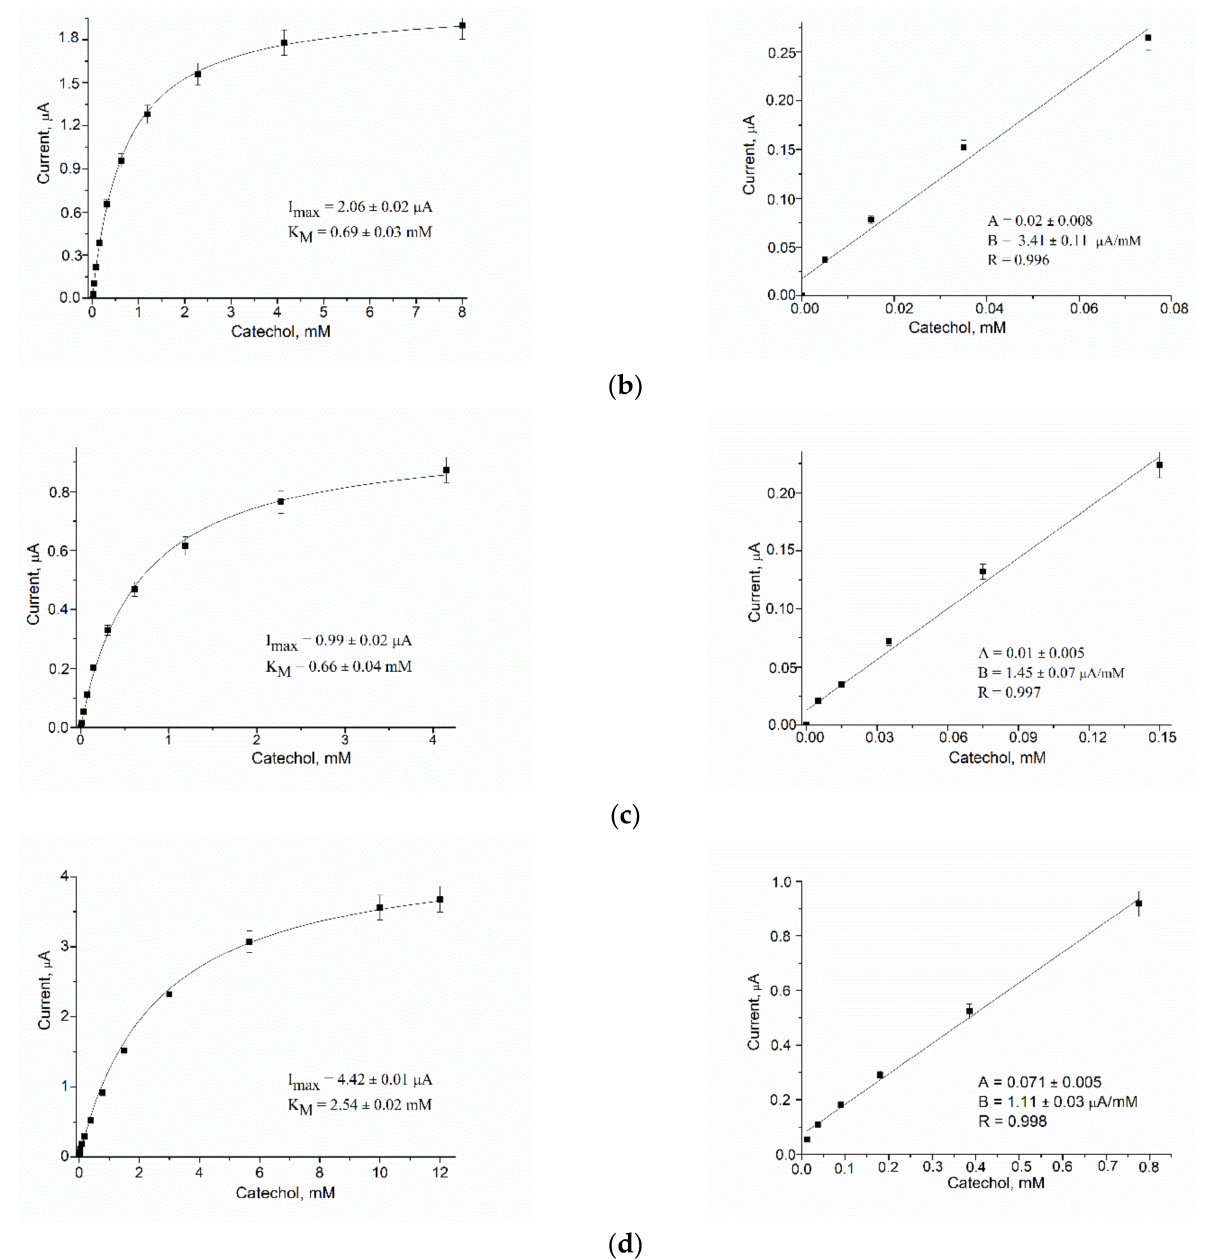
Figure A3. Calibration curves for catechol determination in wide (left) and linear (right) ranges using the laccase-based ABSs which contain electroactive NPs: ( a ) PtHCF, ( b ) AuHCF, ( c ) PtCeHCF, ( d ) AuCuHCF. Conditions: Ag/AgCl (reference electrode) in NaOAc buffer. Working potential: +230